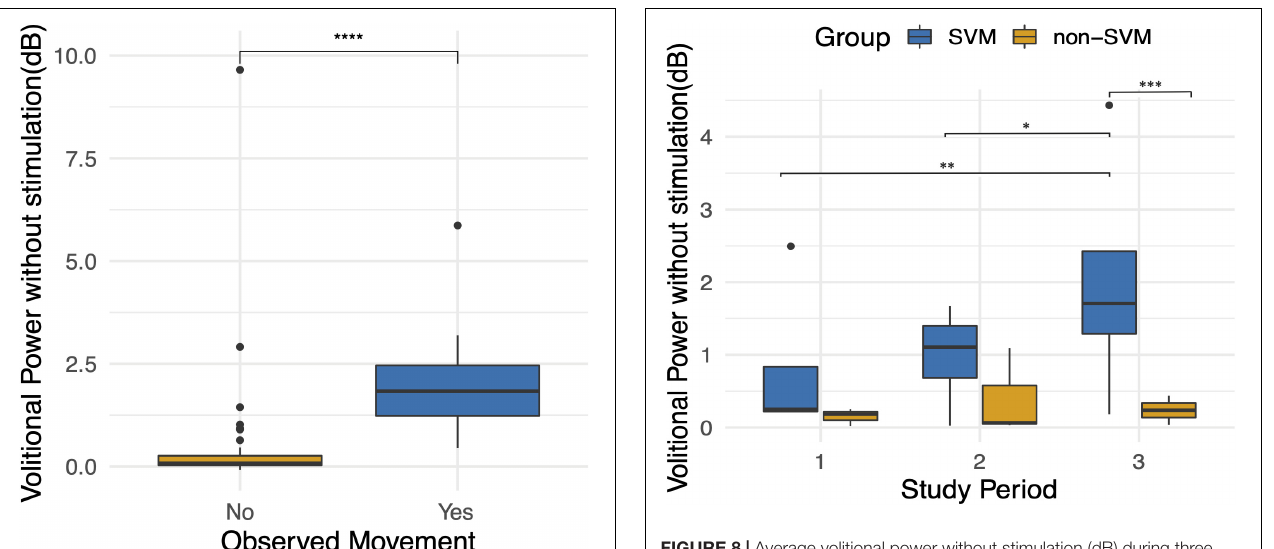
FIGURE 8 | Average volitional power without stimulation (dB) during three follow-up study periods. Study period 1 included follow-up visits 1–5. Study period 2 included follow-up visits 6–9. Study period 3 included follow-up visits 10–13. An improvement over time is apparent only in the SVM group and is statistically significant between study periods 1 and 3 ( p = 0.008) and between study periods 2 and 3 ( p = 0.03). Volitional power between SVM and non-SVM groups is significantly greater in study period 3 ( p < 0.001). * p < 0.05, ** p < 0.01, *** p < 0.001. level, vertebral fracture level, fusion level, and imaging